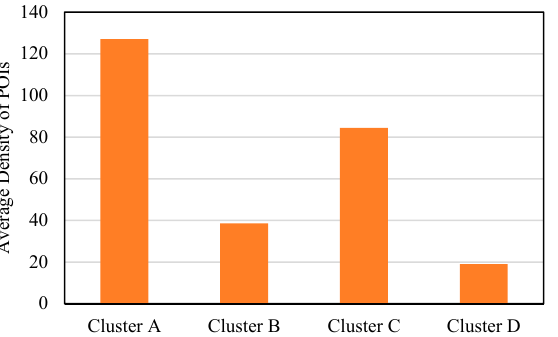
Figure 10. The spatial distribution of POIs in the DP peninsula. Note: the density of POIs is obtained using the KDE with the parameters being the same as the other analyses. The average value is obtained based on all the grids (n = 10,486) in the peninsular.